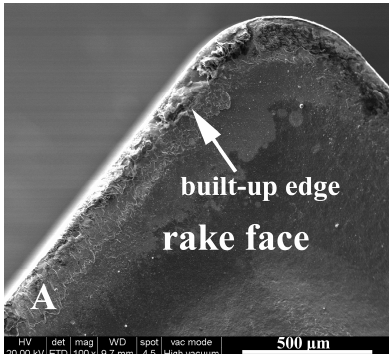
Figure 8. SEM image of rake face of the TiAlN-coated insert after machining for 6 min (cutting speed of 50 m/min, feed rate of 0.1 mm/r, depth of cut of 1.0 mm).